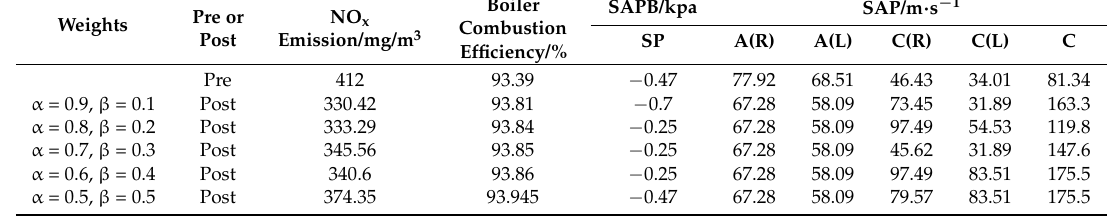
(1)–(6) The value of boiler operation parameters before and after optimization of MR-PSO